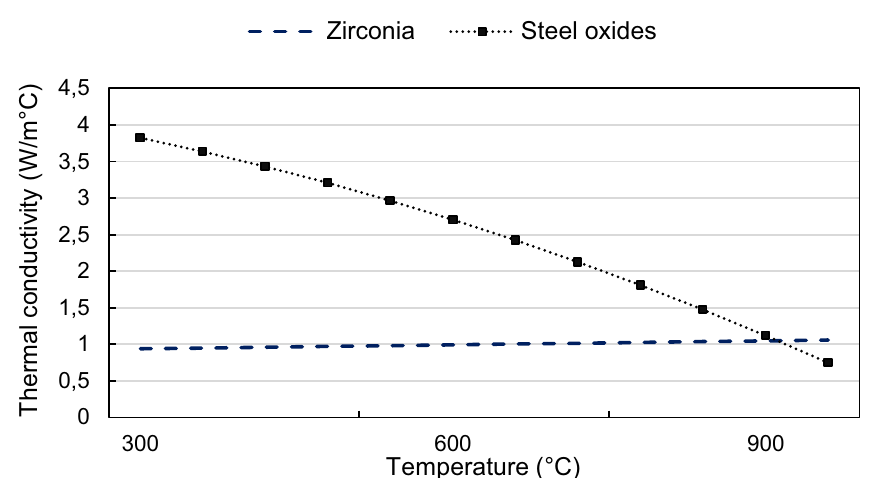
Fig. 1. Thermal conductivity data from literature [6] as a function of temperature of steel oxides and zirconia.